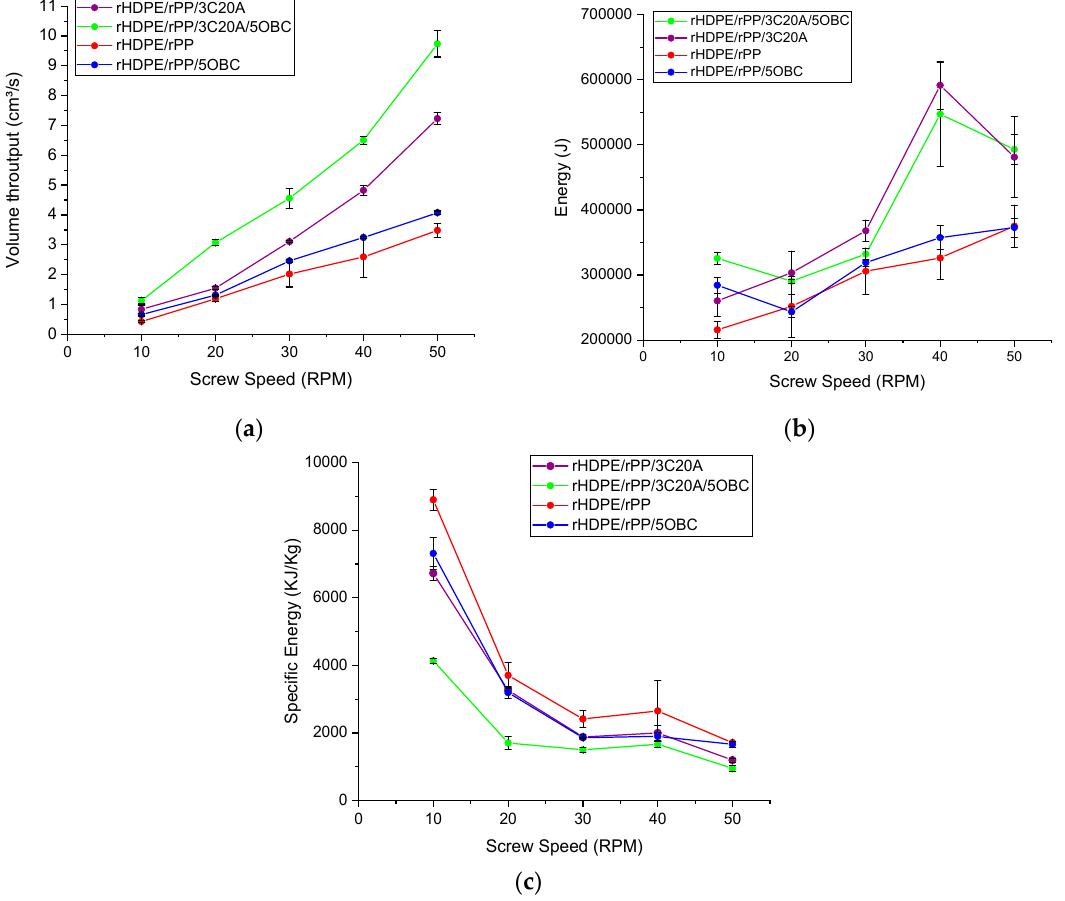
Figure 10. Volume throughput ( a ), energy ( b ), and specific energy ( c ) as a function of screw speed.